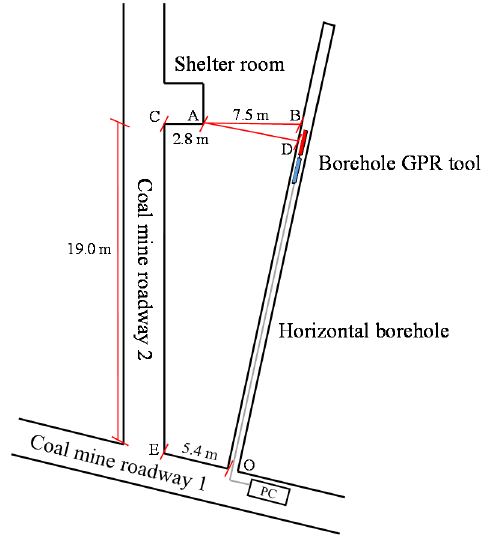
Figure 3. Geometry setup of controlled single borehole GPR test. AB, AC, CE, and EO separation is 7.5, 2.8, 19.0, and 5.4 m, respectively, according to the roadway design. AD, BD, and DO separation can be calculated as 7.28, 1.81, and 19.12 m, respectively.